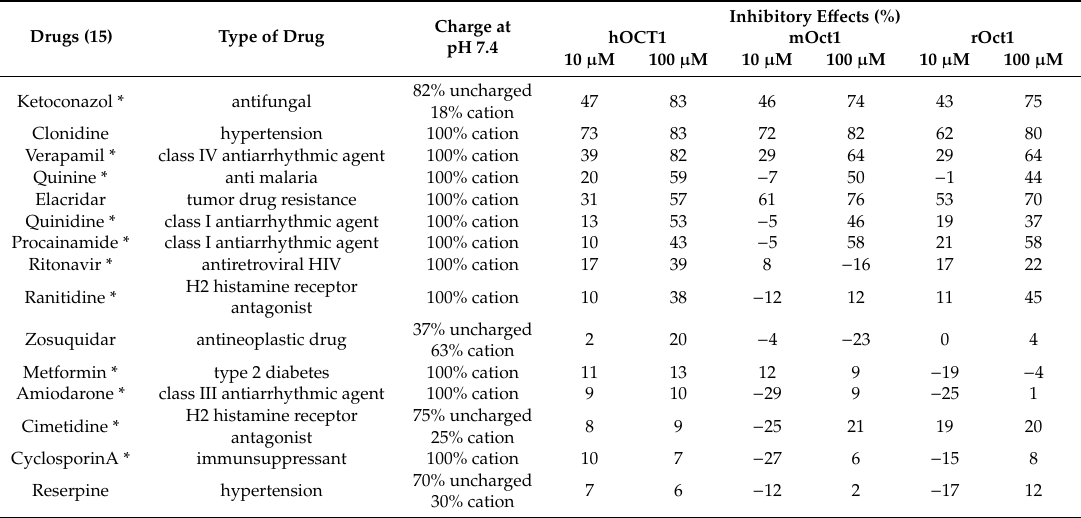
Table 1. Inhibitory e ff ects of various cationic drugs to human, mouse and rat OCT1-mediated 3 H-MPP